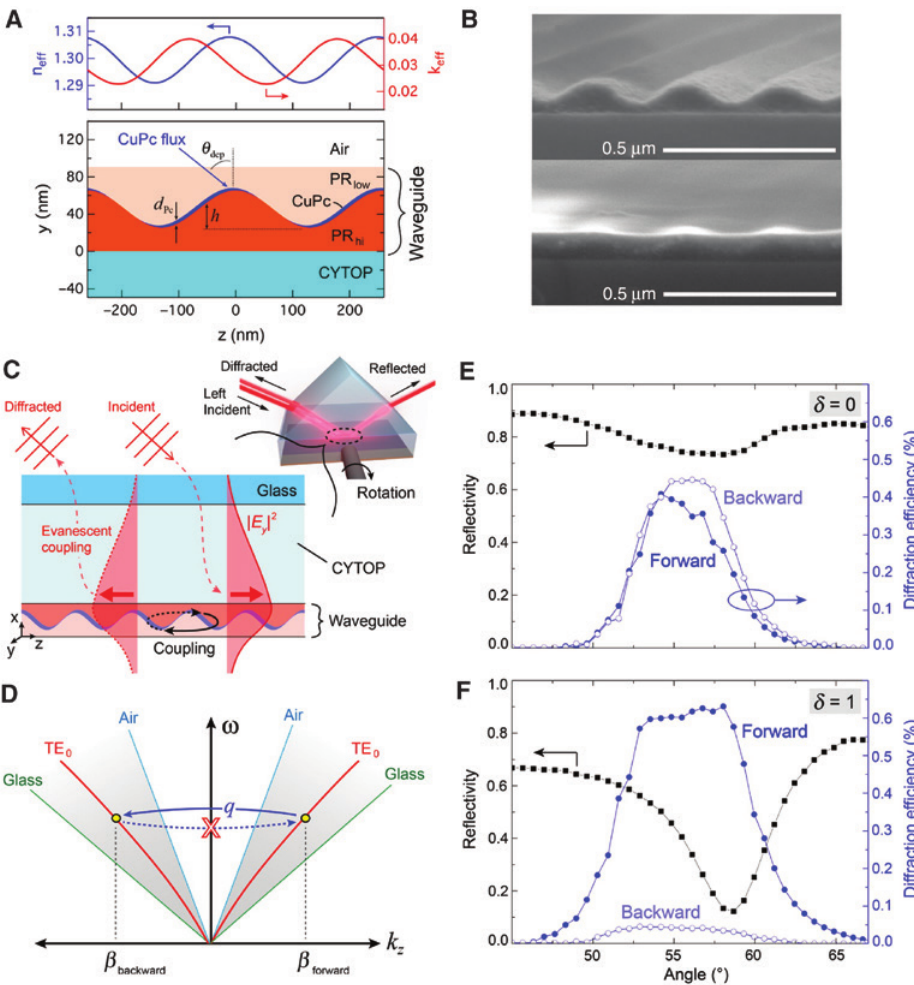
Figure 4: Unidirectional reflectionlessness of passive PT -symmetric organic thin-film waveguides. (A) Waveguide composition calculated to support the fundamental leaky TE mode together with its corresponding position-dependent + ik complex effective index n displayed in the top panel. (B) Cross-sectional SEM images of a typical CuPc-coated photoresist grating eff eff before (top) and after (bottom) planarization with the top photoresist layer. Faint contrast between the upper and lower photoresist layers remains visible in the bottom panel, confirming that the internal grating structure is maintained. (C) Diagram showing the optical measure- ment setup, where a laser beam is Kretschmann coupled into the leaky TE mode supported by the composite waveguide layer. The intensity 0 of the 0 order reflected and - 1 order diffracted beam is measured as a function of incidence angle for forward and backward illumination corresponding to light incident on the left and right sides of the prism, respectively. (D) Dispersion diagram illustrating the process of unidi- rectional scattering within the complex index modulated waveguide that occurs at its EP. (E) Reflectivity and −1 order diffraction efficiencies measured as a function of incidence angle (in the glass substrate) for a bare waveguide with no CuPc. The diffracted intensities for forward ~ 56 ° ), which is designed to coincide with resonant in-coupling to the wave- and backward incidence peaks near the Littrow condition ( θ inc = 6 nm, θ = 55 ° ) targeted guide mode marked by the reflectivity dip. (F) The same measurement carried out for a waveguide with CuPc ( d PC dep to achieve δ ≈ 1